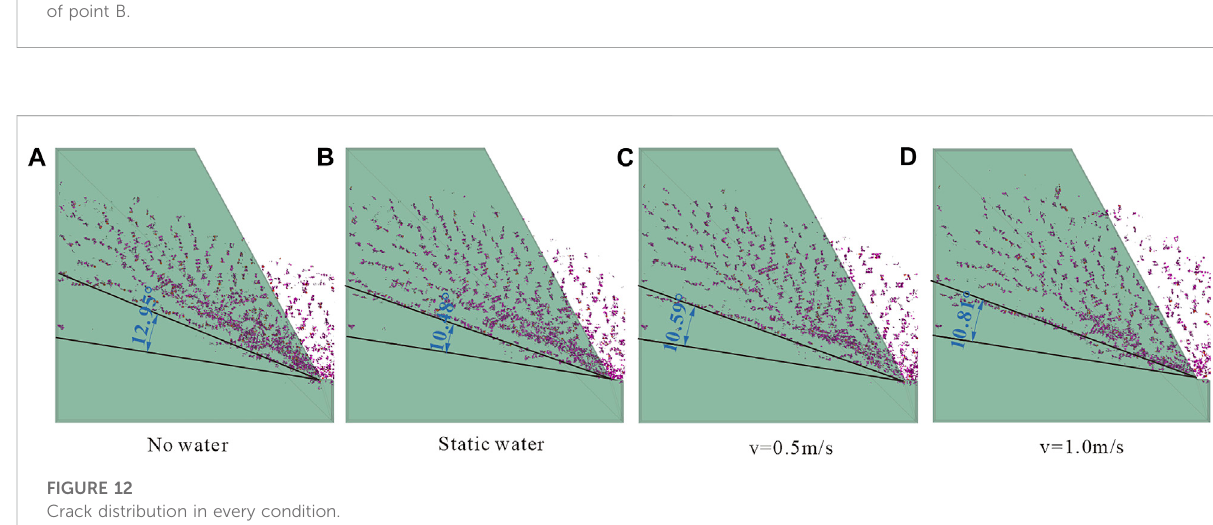
(2) Collapse load: the collapse load predicted from PFC3D is 92 g, and it is near to that in the original centrifuge test result (80 – 85 g); (3) Horizontal displacement: as shown in Figure 7, the horizontal displacement – gravity load curve is compared